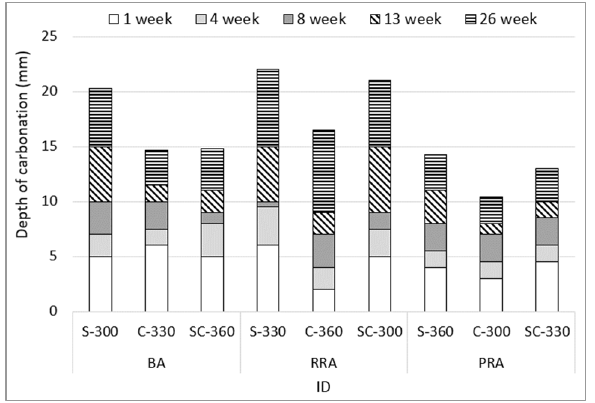
Figure 13. Depth of the accelerated carbonation of the concrete.